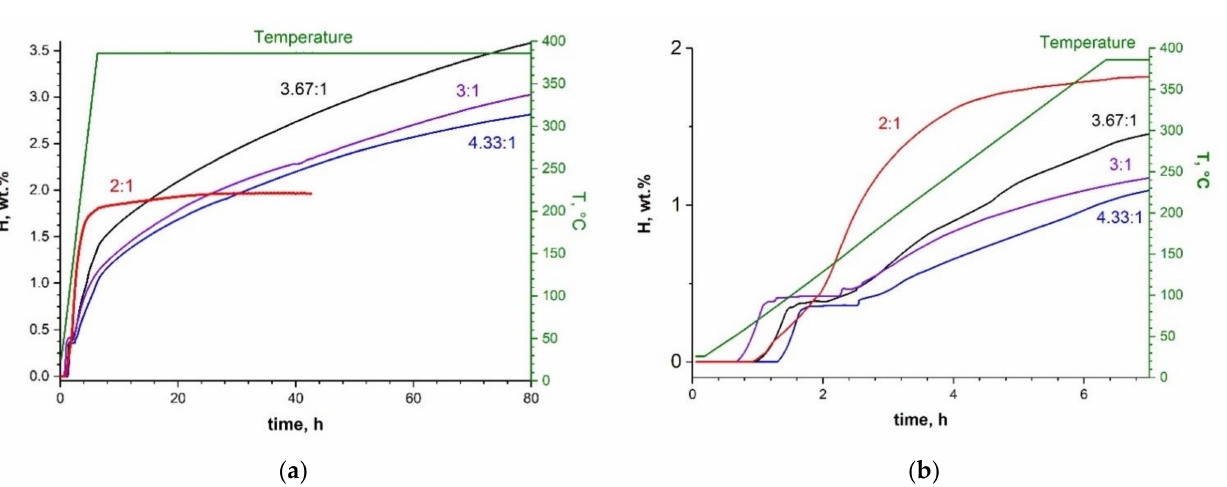
Figure 5. ( a ) TPD of ball-milled LiBH 4 –AlCl 3 mixtures taken in different molar ratios of starting materials. The green line represents temperature profile. The desorption curves were obtained during heating from room temperature to 385 ◦ C with a heating rate of 1 ◦ C/min. ( b ) Zoomed plot representing the TPD during the first 7 h of measurements. Table 4. Hydrogen desorption characterization and RGA analysis of decomposition products